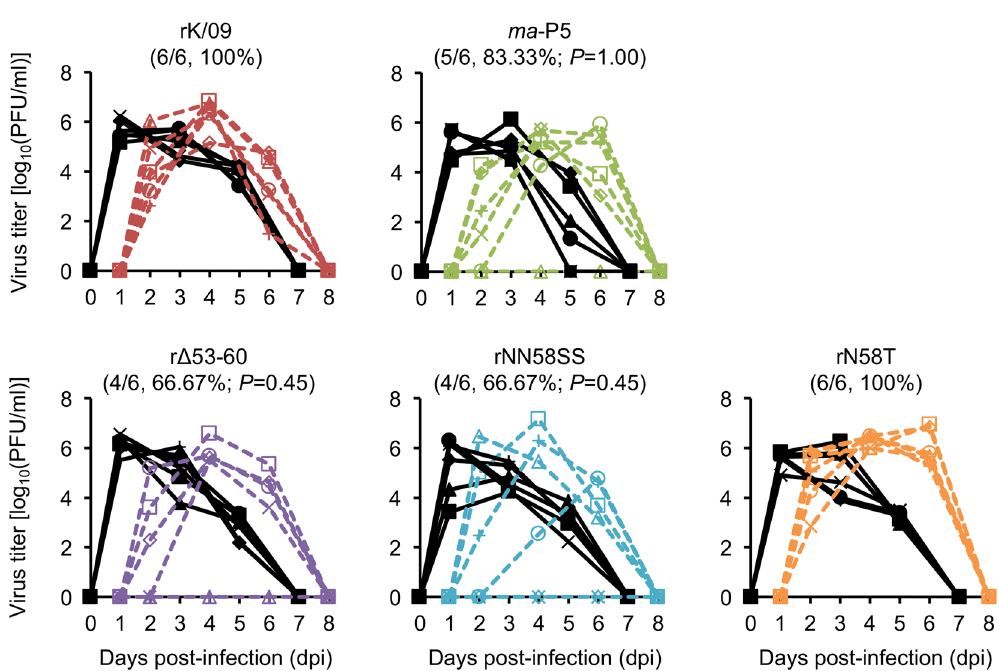
Figure 6. Transmissibility of the rK/09 and its NA stalk mutant viruses in guinea pigs. Transmission efficiency of rK/09, ma -P5, r Δ 53–60, rNN58SS, and rN58T was examined in guinea pigs. Solid lines represent the nasal wash titers of infected guinea pigs, and dotted lines represent those of contacts. Transmission efficiency of each virus group is indicated in parenthesis as the ratio of the number of contact guinea pigs versus the number of infected guinea